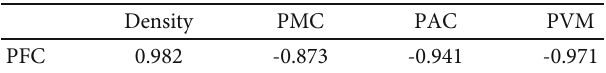
Table 3: Correlations of average energy properties of wood samples with its percentage of fi xed